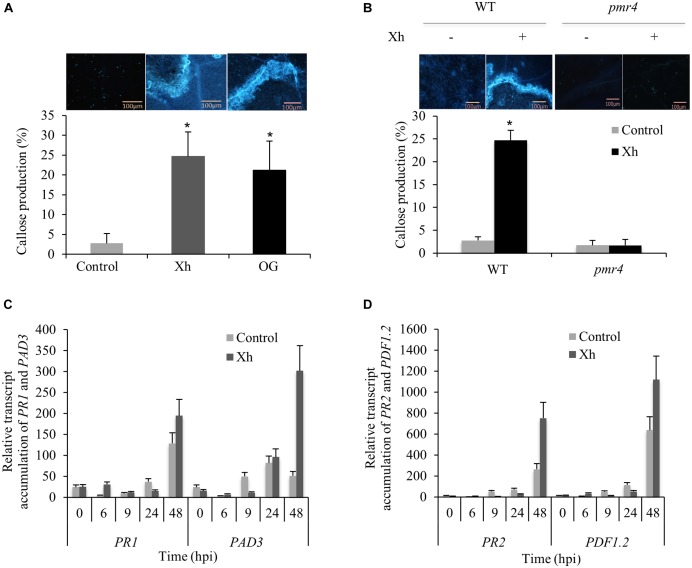
Xh trigger a PMR4-dependent callose deposition in Arabidopsis and the overexpression of defense genes during B. cinerea infection. (A) Callose quantification at 3 dpi detected by aniline blue staining in Arabidopsis Col-0 plants treated with water (control), Xh, or OG (2.5 mg/ml). (B) Callose quantification at 3 dpi detected by aniline blue staining in WT (Col-0) and pmr4 mutant treated with water (–) or Xh (+; 2.5 mg/ml). Values represent means ± SD of at least 10 observed fields. A representative fluorescence microscopy imaging for each treatment is shown. Bar: 100 μm. Asterisks indicate statistically significant differences between control and elicitor-treated plants using a Student’s t-test (P < 0.05). Time course of relative expression of defense genes encoding pathogenesis-related protein 1 (PR1; C), phytoalexin deficient 3 (PAD3; C), pathogenesis-related protein 2 (PR2; D), and plant defensin 1.2 (PDF1.2; D) during Xh-induced resistance against B. cinerea measured by qPCR. Results represent the mean ± SD of three biological replicates after normalization by the housekeeping gene At4g26410 (Czechowski et al., 2005). Hpi, hours post inoculation.